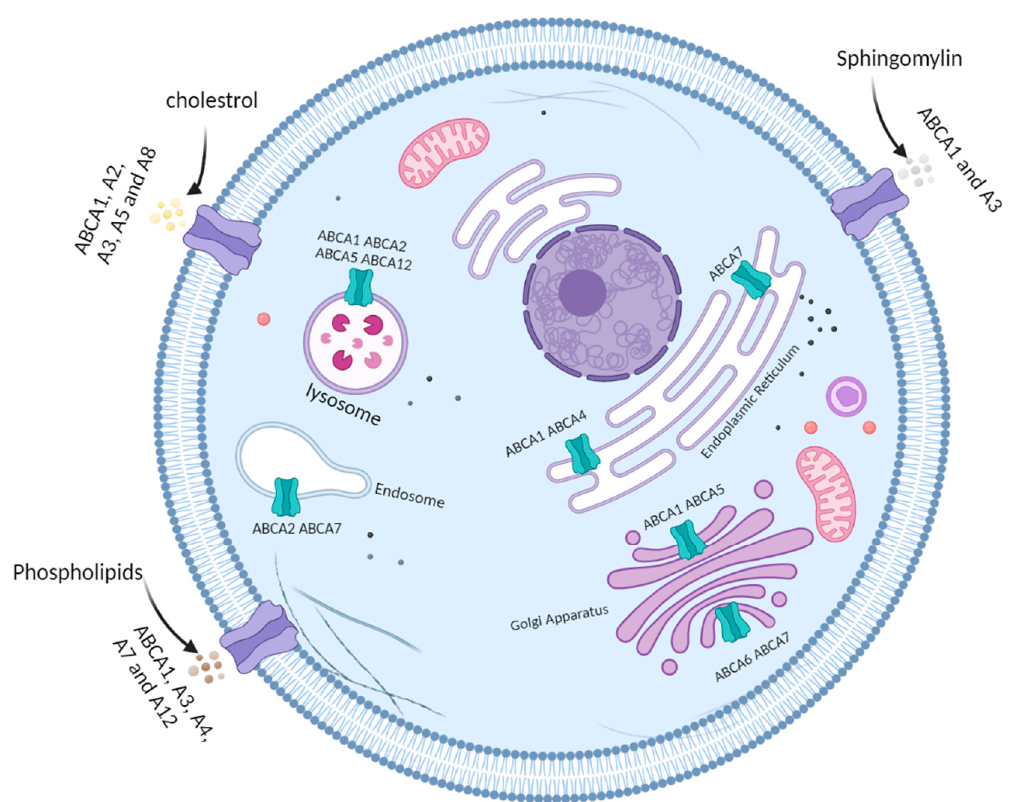
Figure 1. Schematic representation of ABCA subfamily localization and their possible lipophilic substrates. ABCA transporters are localized in the plasma membrane of the cells or in the membrane of specific intracellular organelles such as the lysosome, endosome, endoplasmic reticulum and the Golgi apparatus. Twelve members of the ABCA subfamily of transporters abbreviated ABCA1 through ABCA13 enable the transfer of lipids. ABCA 1, 2, 3, 5 and 8 modulate cholesterol transport. ABCA 1, 3, 4, 7 and 12 transport phospholipids, while ABCA 1 and 3 control the movement of sphingomyelins. Figure generated by BioRender.